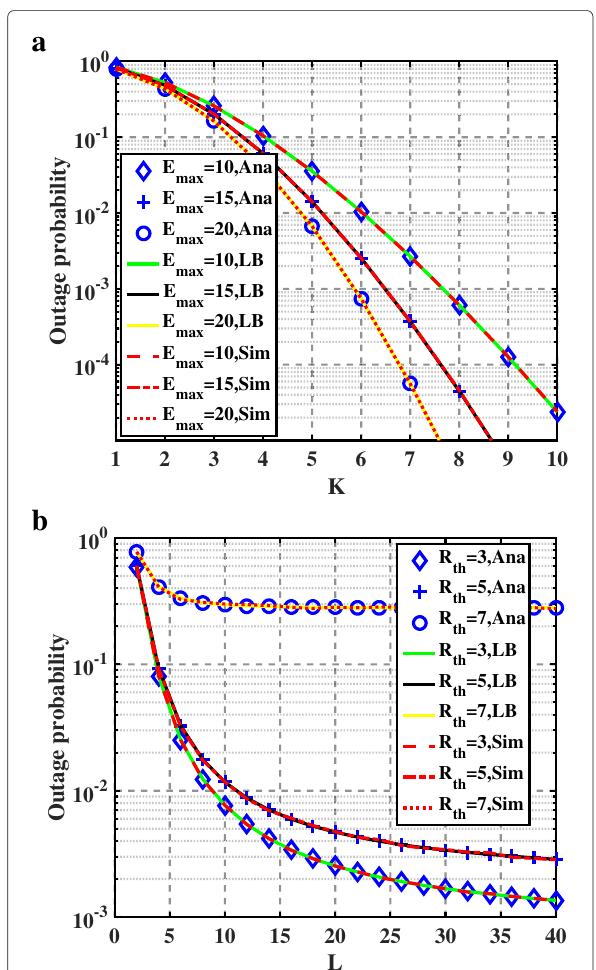
Fig. 5 Outage probability vs. the number of SUs and the energy levels. a Emax = 10, 15, 20 mW. b Rth = 3, 5, 7 bit/s/Hz